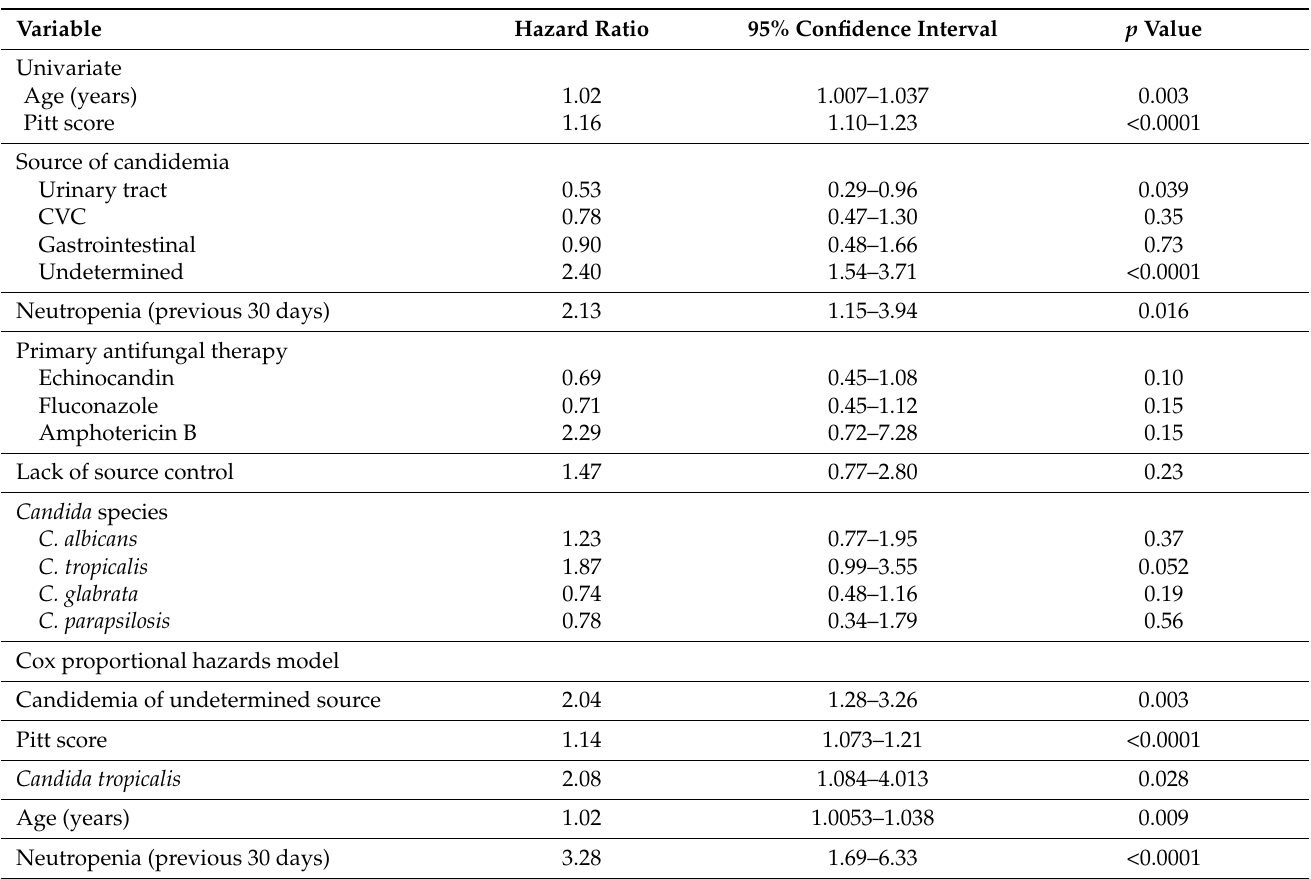
Table 4. Univariate survival analyses and Cox